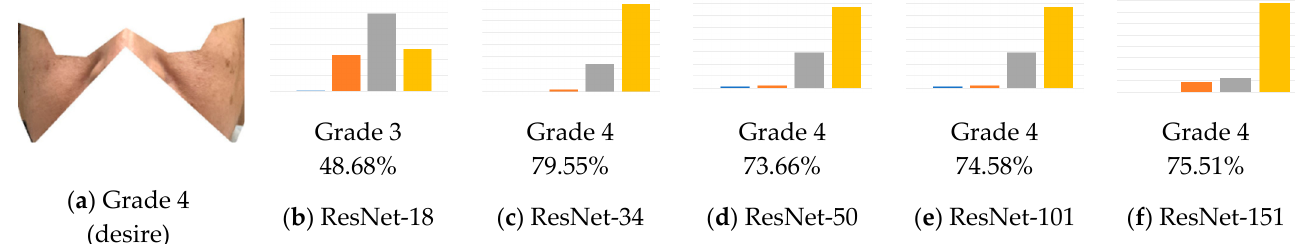
Figure 11. Example and training results of the Grade 4 cheek speckles (wrongly classified grades are underlined).